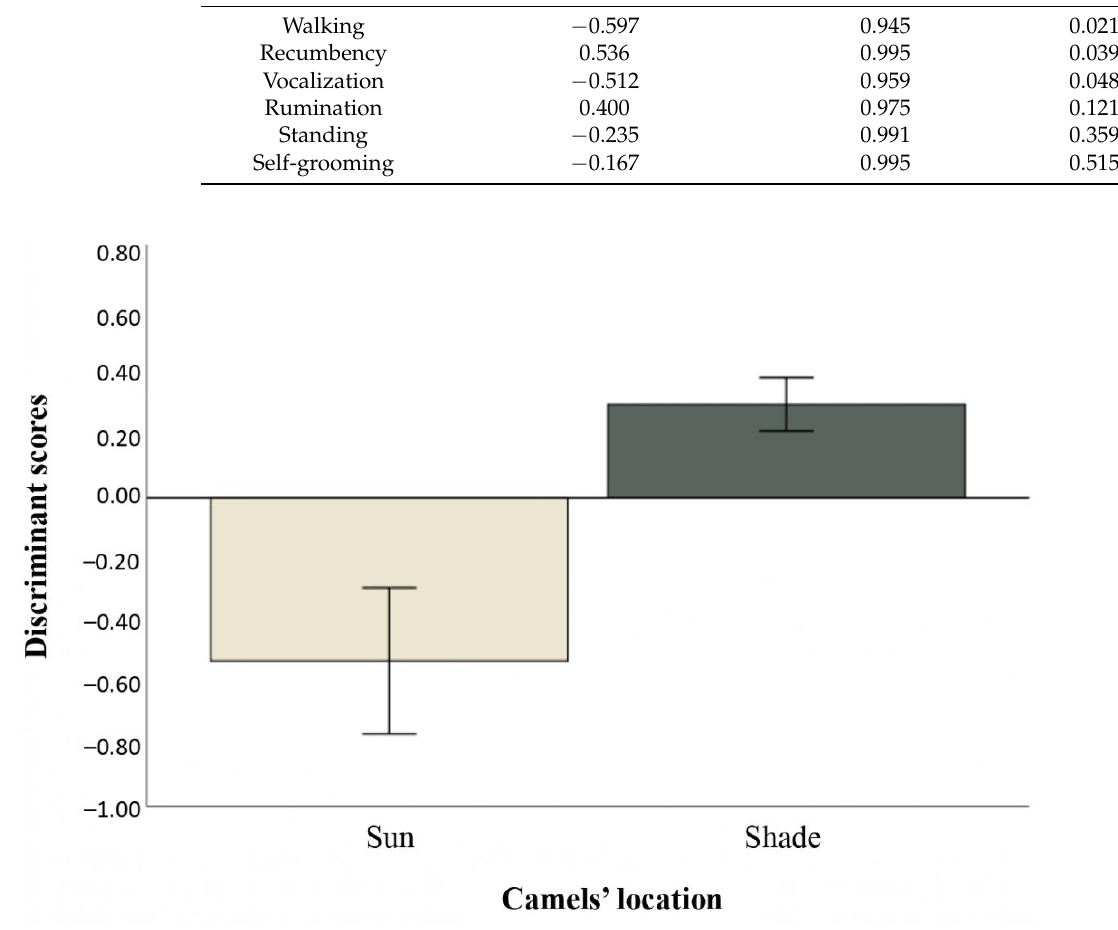
Figure 5. Means and standard errors of the discriminant scores identified for the behaviors of dromedary camels in the sun and shaded areas of pens in the Doha market. Walking, recumbency, and vocalization were the behaviors that significantly contributed to the discriminant function.